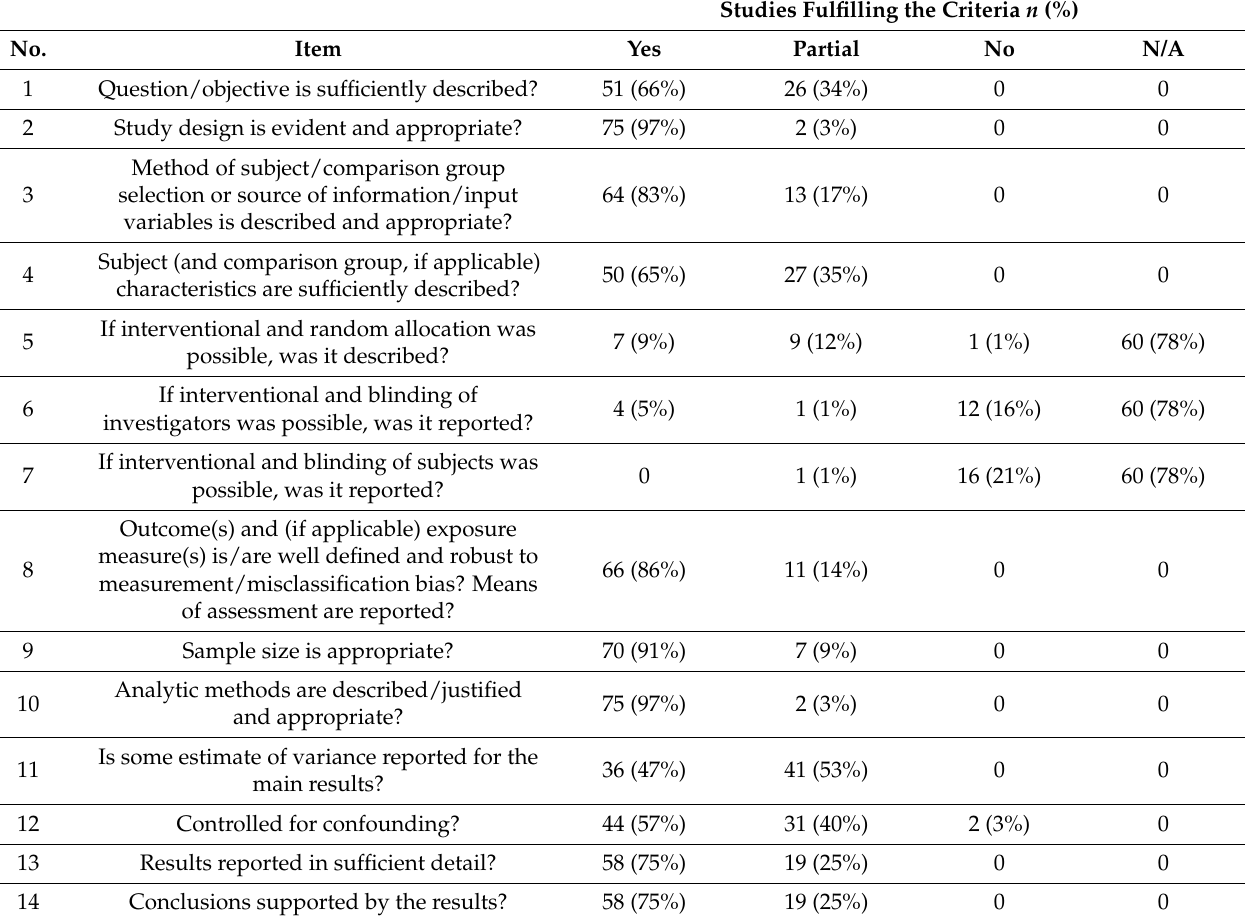
Table 3. Criteria for the methodological quality assessment and the number (%) of studies that scored points or each